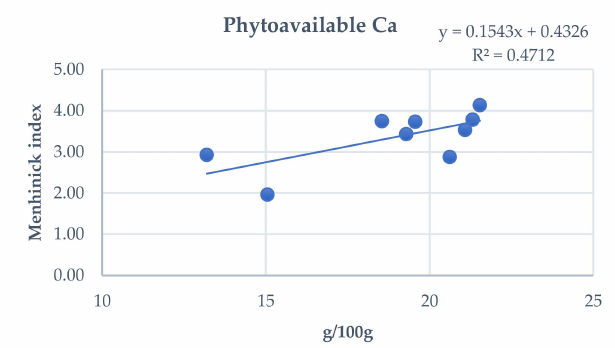
Figure 8. Relationship between the available Ca and the Menhinick richness index.